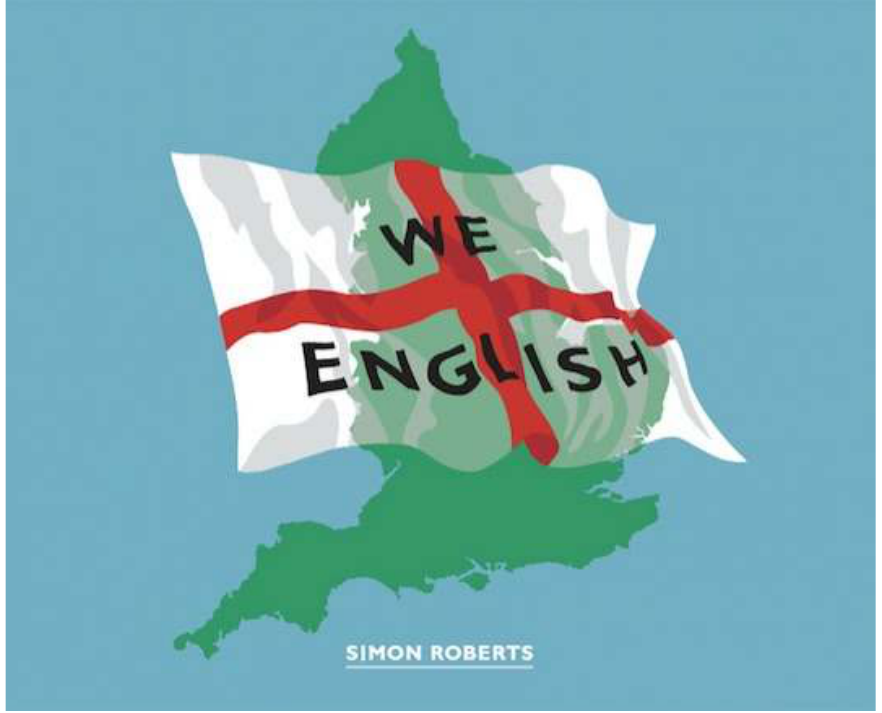
Figure 1: Simon Roberts, We English